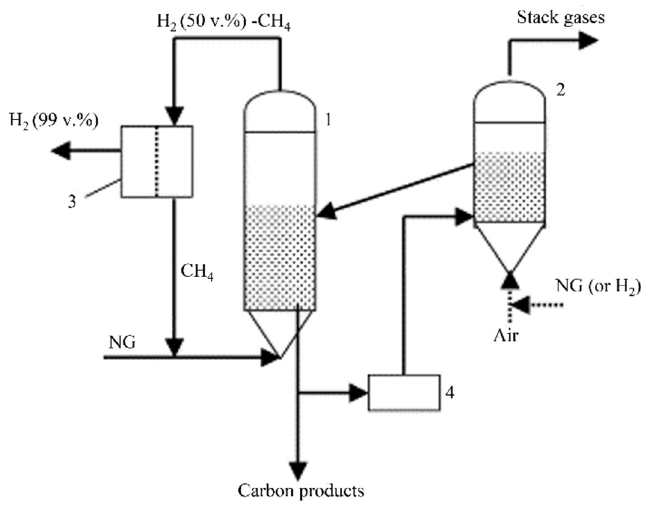
Figure 3. The general process of catalytic decomposition of methane to produce hydrogen [15]. 1—Fluidized bed reactor, 2—Heater, 3—Gas separation unit, 4—Grinder.